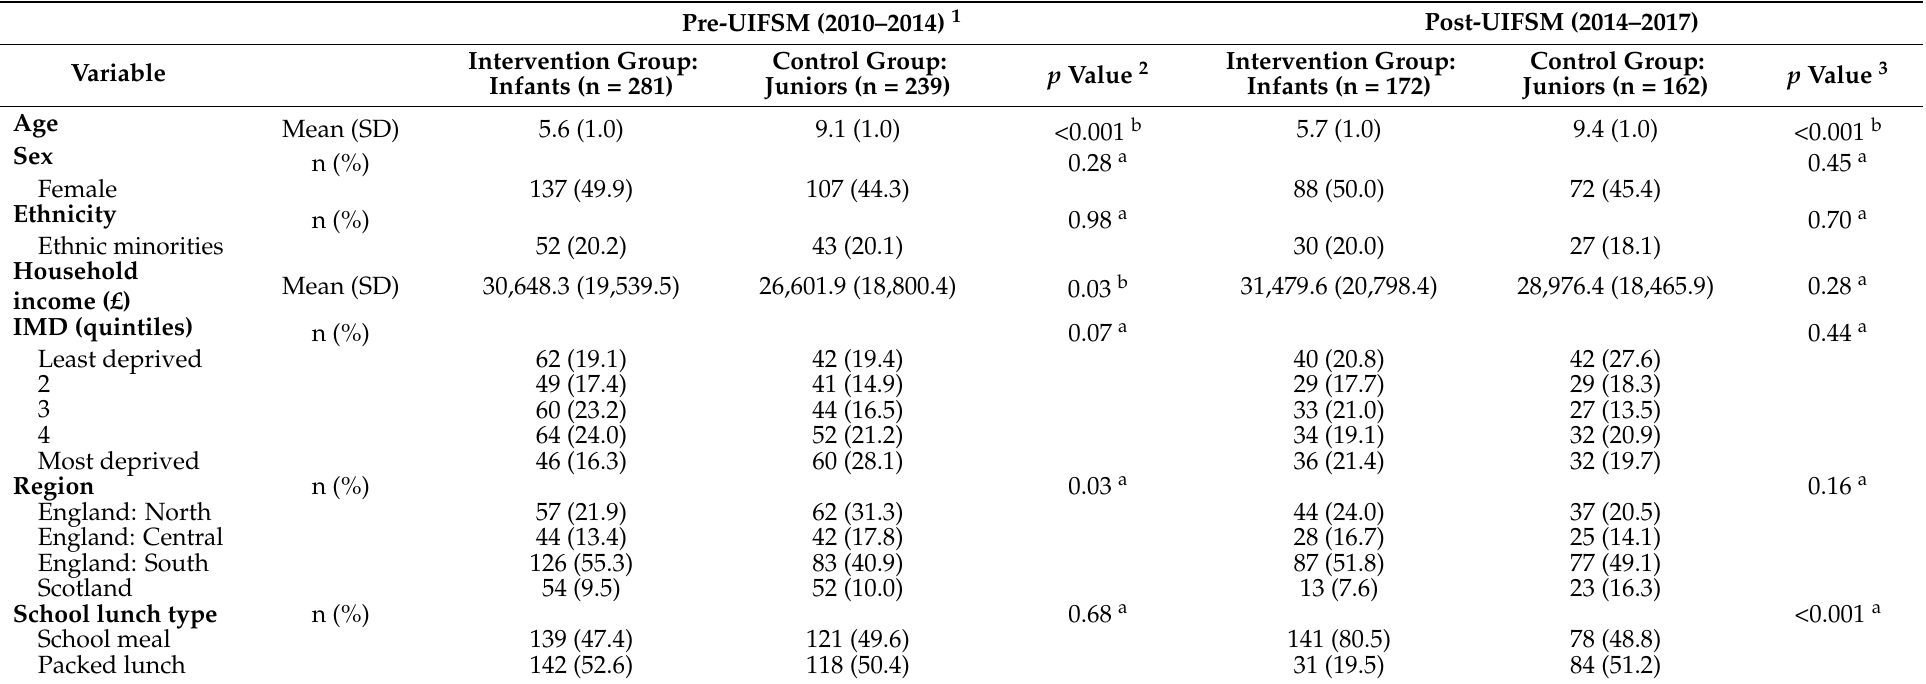
Table 1. Characteristics of schoolchildren (n = 854) in England and Scotland before and after implementation of the UIFSM